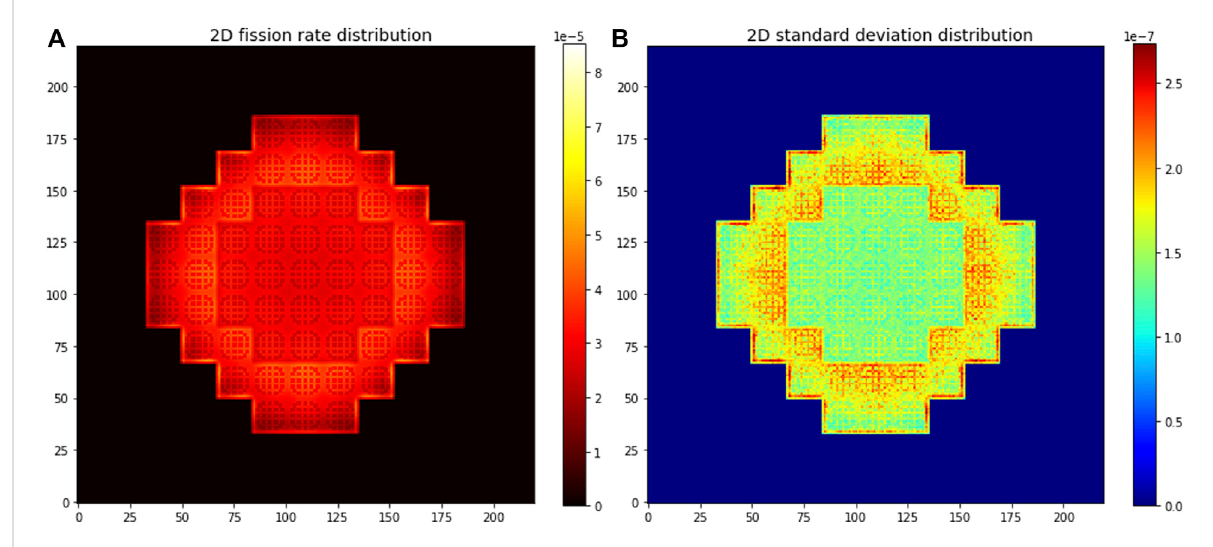
FIGURE 8 Fission rate and standard deviation distributions of two-batch refuelling scheme core with light water re fl